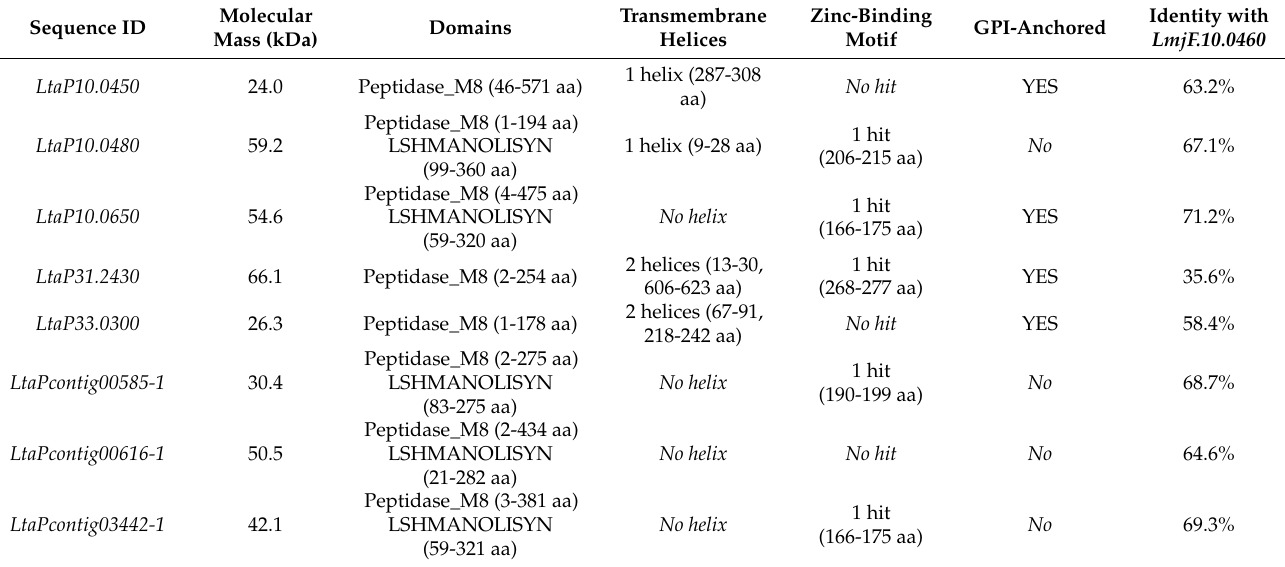
Table 1. Leishmanolysin sequences from Leishmania tarentolae